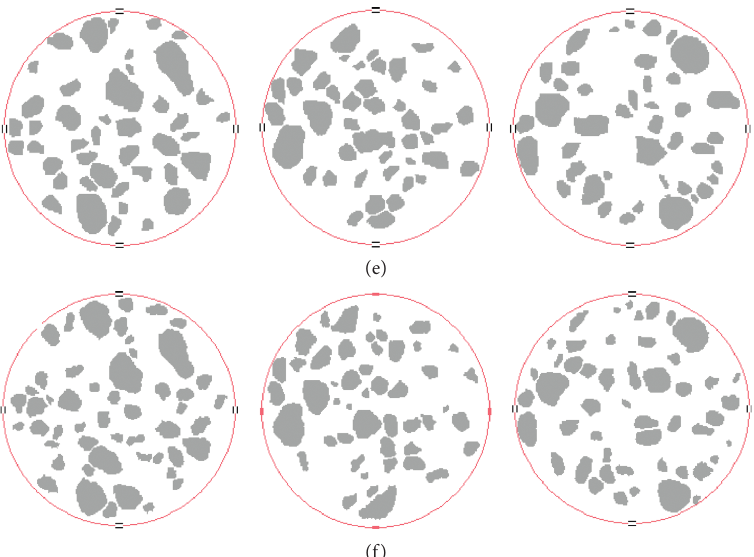
Figure 5: Rock block extraction from the CTimages at different deformation stages. (a) ε � 0%. (b) ε � 1.756%. (c) ε � 3.106%. (d) ε � 4.427%. (e) ε � 6.649%. (f) ε � 8.059%.